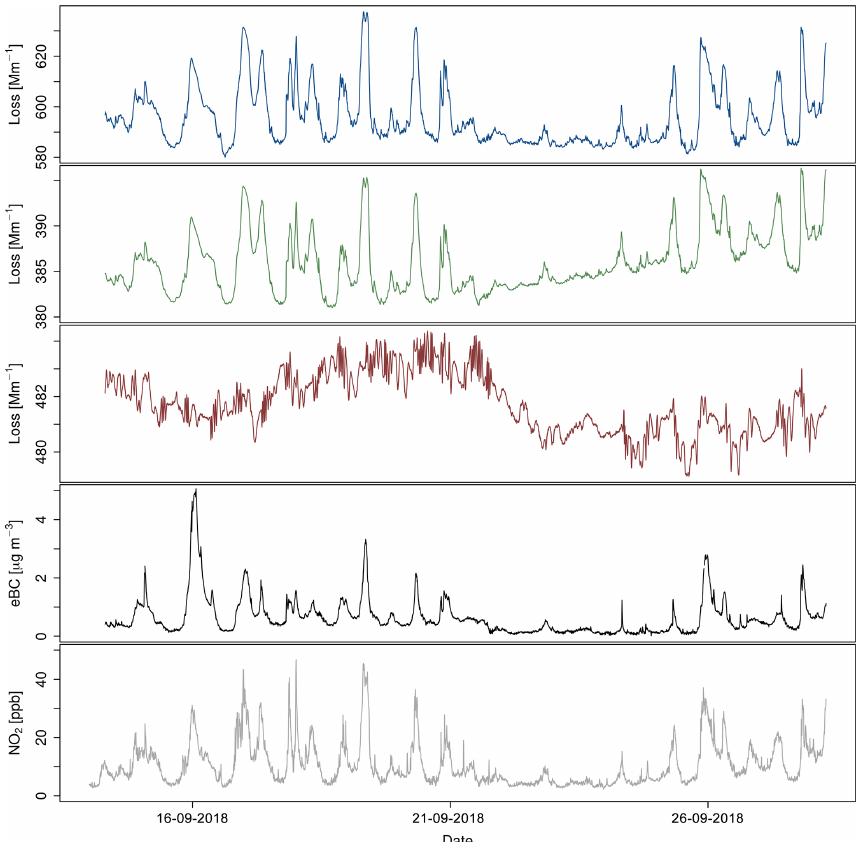
Figure 1. Time series of loss signal measuring particle-free ambient air (450, 530 and 630nm) and eBC and NO 2 concentration for a 2-week